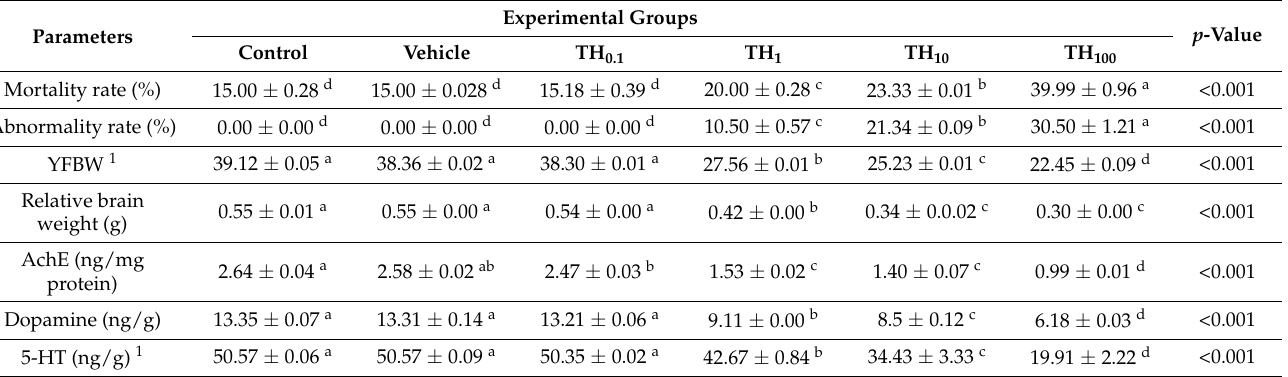
Table 2. Concentration effect of thiacloprid (TH) on the prevalence of malformation, mortality rates, and brain neurochemistry in 19-day-old chicken